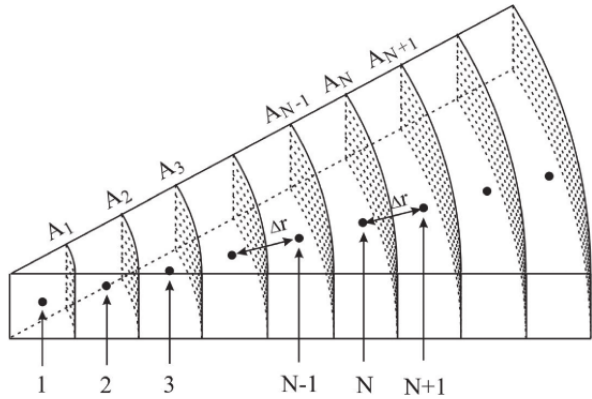
Fig. 3: An 1-D enmeshment setting for discretization of equation 1 for a unit